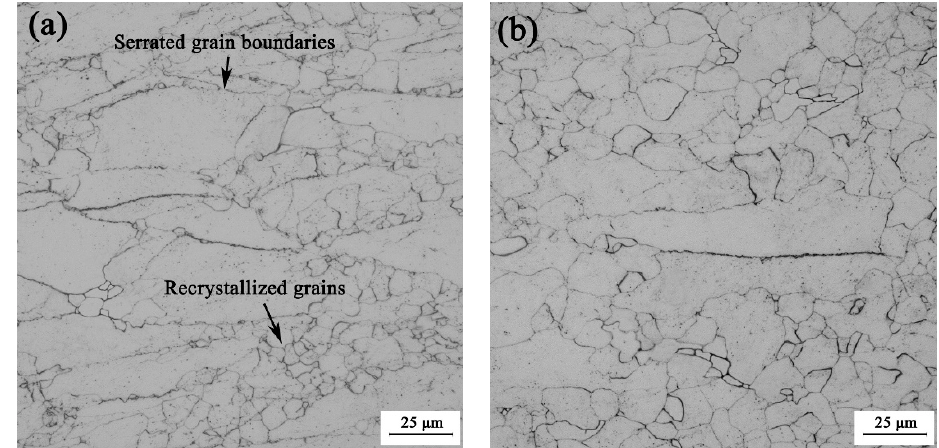
Figure 14. Microstructures of the experimental steel at the hot deformation conditions of: ( a ) 950 °C/10 s − 1 and ( b ) 1000 °C/10 s − 1